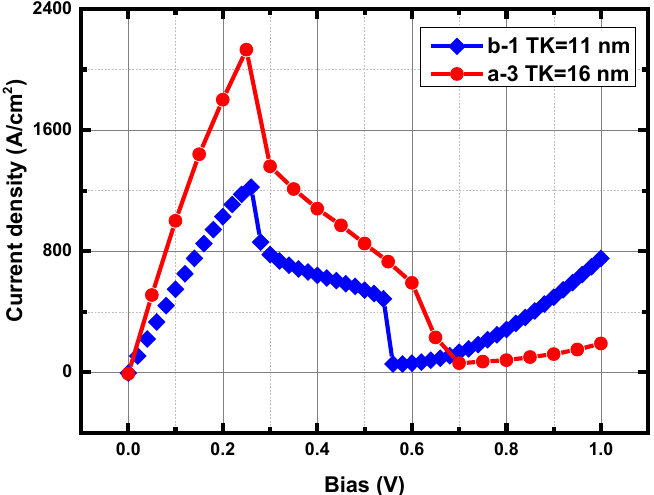
Figure 5. Experimental results of tunnel-junction devices under various thickness of the In 0.07 GaAs layer. Figure5. Experimentalresultsoftunnel-junctiondevicesundervariousthicknessoftheIn 0.07